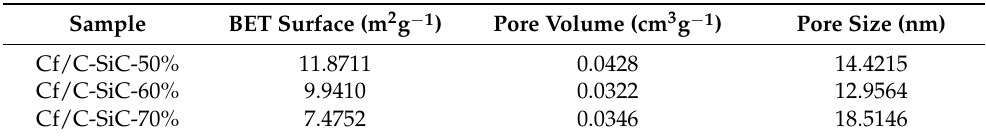
Figure 5. ( a ) Nitrogen sorption isotherms; ( b ) BJH pore size distributions of the Cf/C-SiC composites prepared by different binder content. Table 3. BET test data of samples.